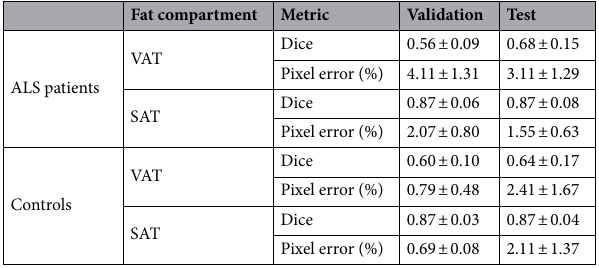
Table 1. Average network performance in validation and test data sets. VAT—visceral adipose tissue; SAT— subcutaneous adipose